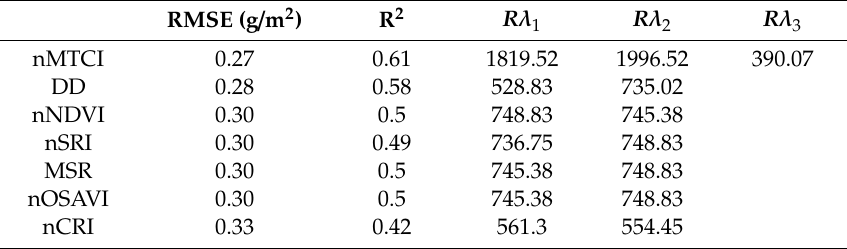
Table 2. RMSE and R 2 of the most accurate band combinations for all tested narrowband vegetation indices. Leave-one-out cross-validation was used to verify the models. All listed models were statistically significant ( p < 0.01). Vegetation indices are listed by lowest cross-validated RMSE in descending order. R (nm) is the reflectance at the corresponding wavelength λ